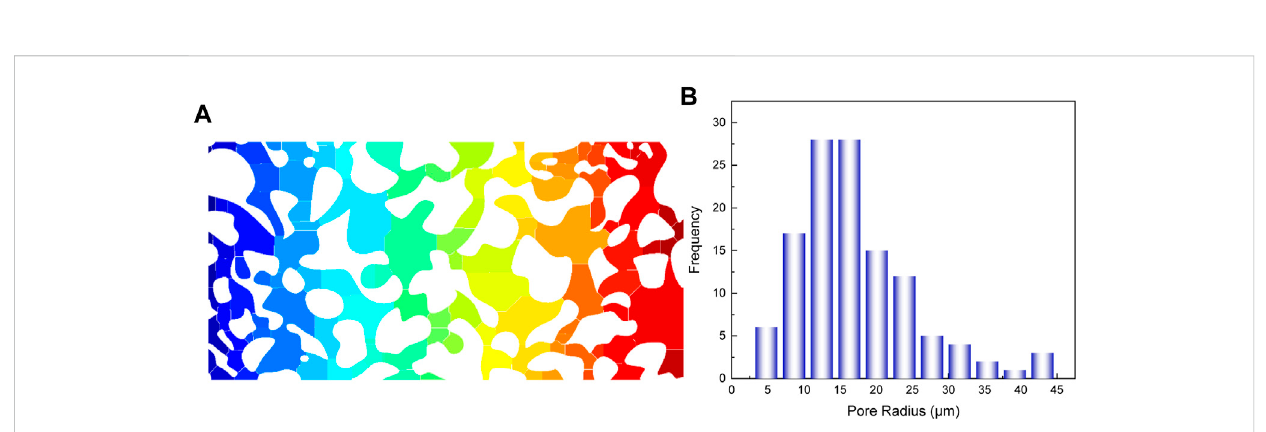
FIGURE 10 (A) Separation of pores based on the watershed segmentation algorithm, and (B) the pore size distribution of the SEM pore